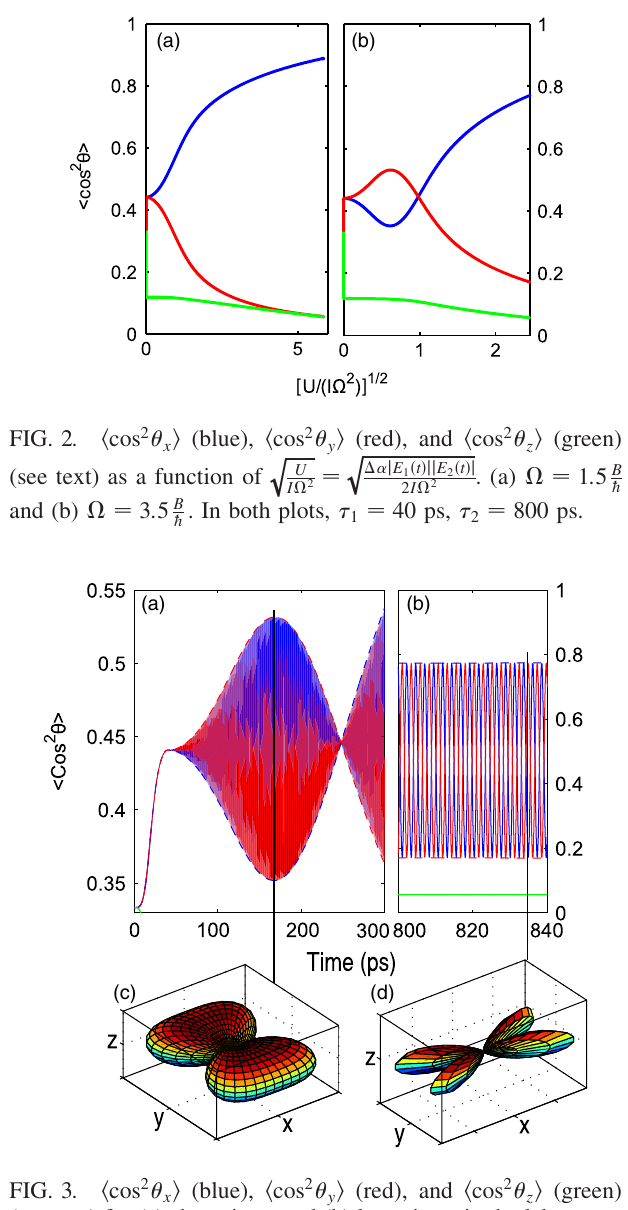
FIG. 3. h cos 2 (cid:2) x i (blue), h cos 2 (cid:2) y i (red), and h cos 2 (cid:2) z i (green) (see text) for (a) short times and (b) long times in the laboratory (solid lines) and the rotating frame (dashed lines). (c) shows the distribution at t ¼ 165 ps . (d) shows the prolate distribution in the rotating frame at time t (cid:1) 840 ps . In (c) and (d), the com- posite laser polarization is along the x axis. For this calculation, ffiffiffiffiffiffiffi q U 0 ¼ 2 : 45 , (cid:1) ¼ 3 : 5 B , (cid:3) 1 ¼ 40 ps , (cid:3) 2 ¼ 800 ps . @ I (cid:1) 2